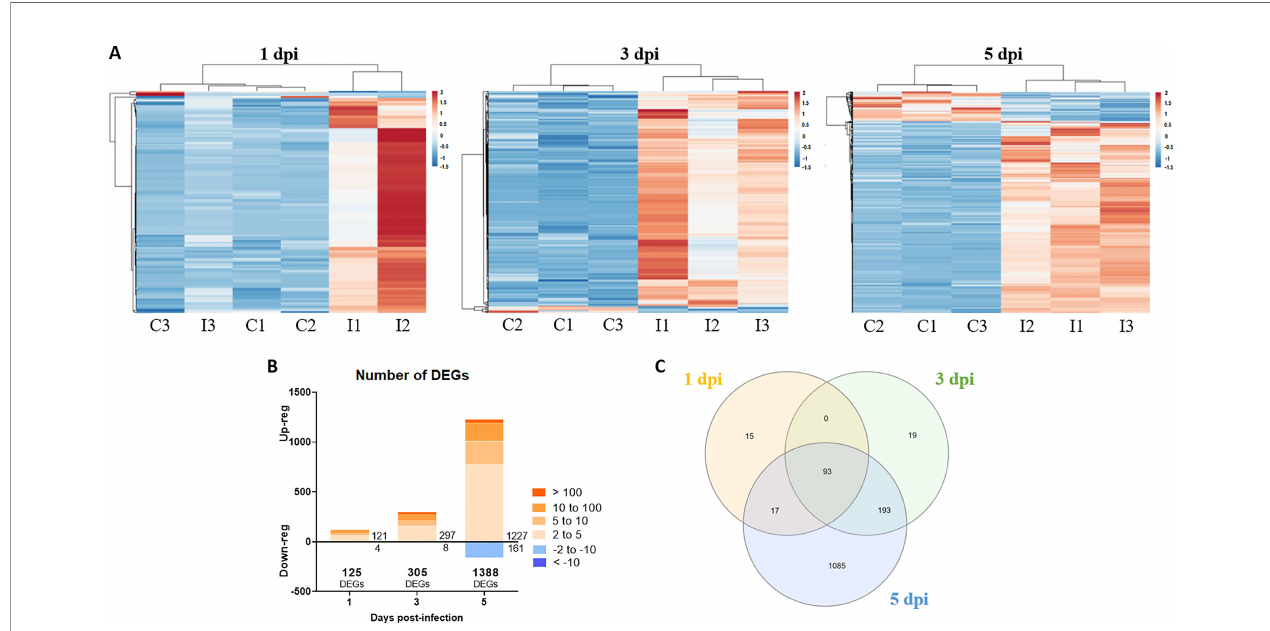
FIGURE 6 | Differentially expressed genes in zebra fi sh larvae infected with NNV. (A) Heatmaps representing the TPM expression values of the DEGs (FC > |2|; FDR < 0.05) modulated at 1, 3 and 5 dpi. Expression levels are represented as row-normalized values on a blue – red colour scale. (B) Stacked column chart re fl ecting the number and intensity (in FC value) of the DEGs identi fi ed at the 3 sampling points. (C) Venn diagram re fl ecting the common and exclusive DEGs at each sampling point.